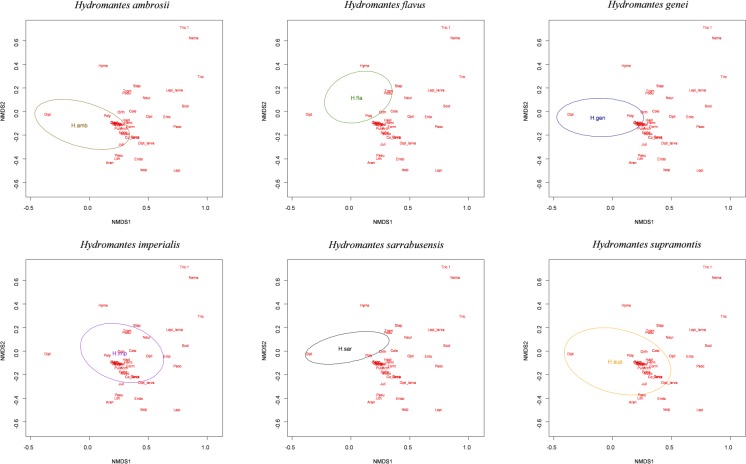
Cumulative NMDS and relative position of each studied species.